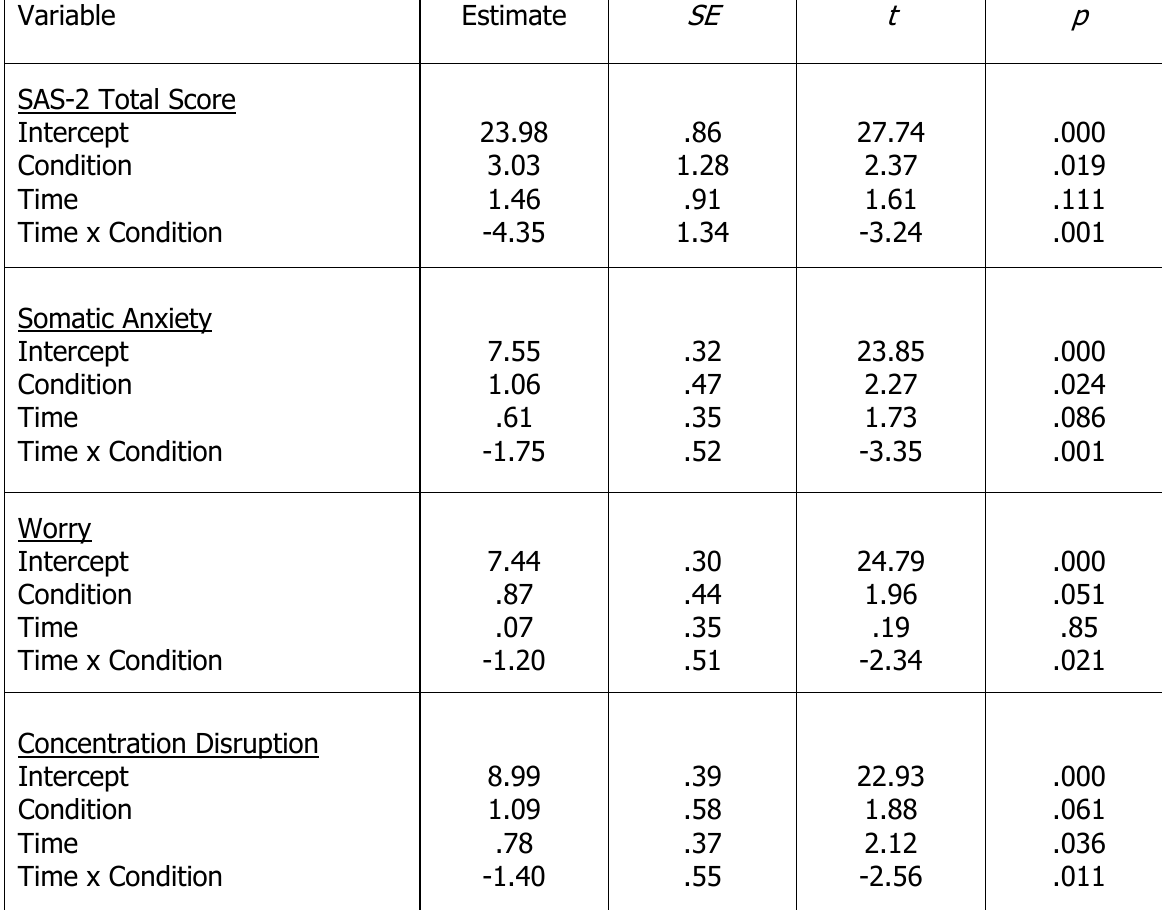
Main and Interactive Effects of Time and Condition upon Change in SAS-2 Scores: Parameter Estimates from Multilevel Linear